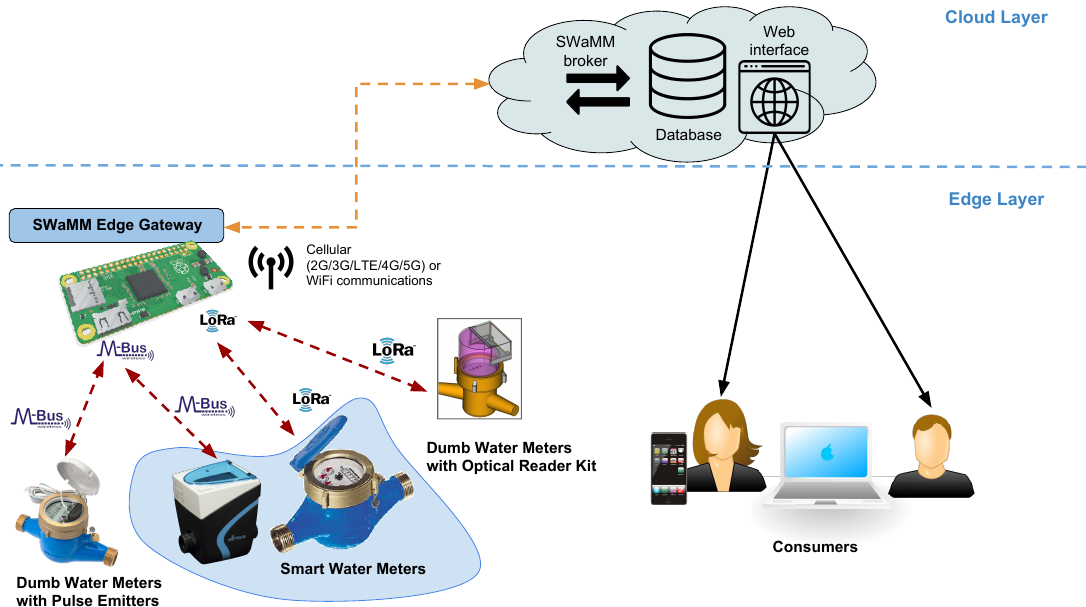
Figure 1. Holistic view of the SWaMM solution: from the smart and traditional water meters to the end-users (consumers and water